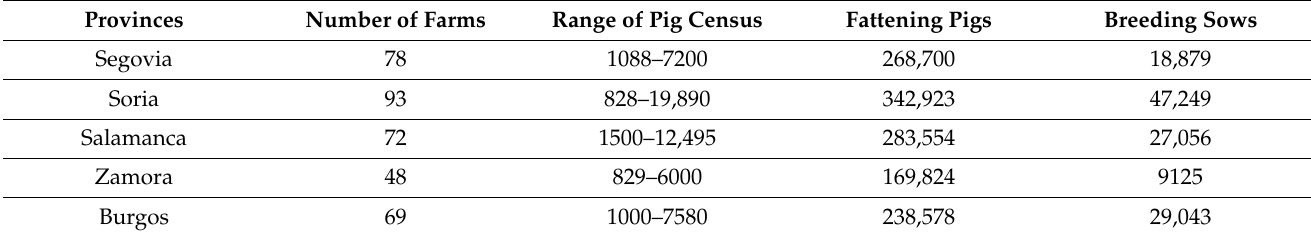
Table 1. Pig census and farm characteristics.